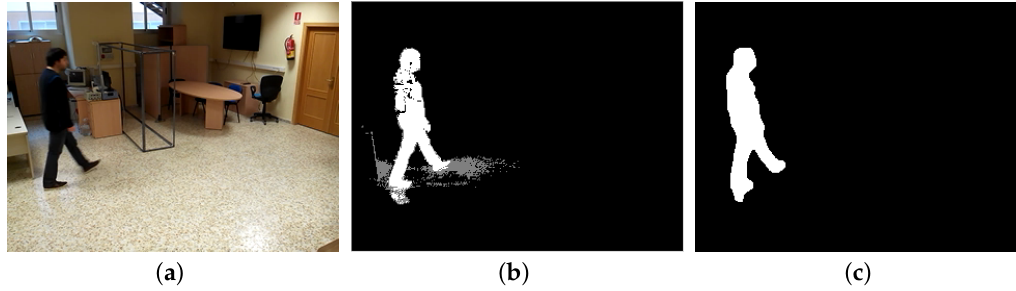
Figure 5. Foreground extraction. ( a ) original image; ( b ) extracted foreground. Areas detected as shadows are coloured in grey; ( c ) final cleaned foreground